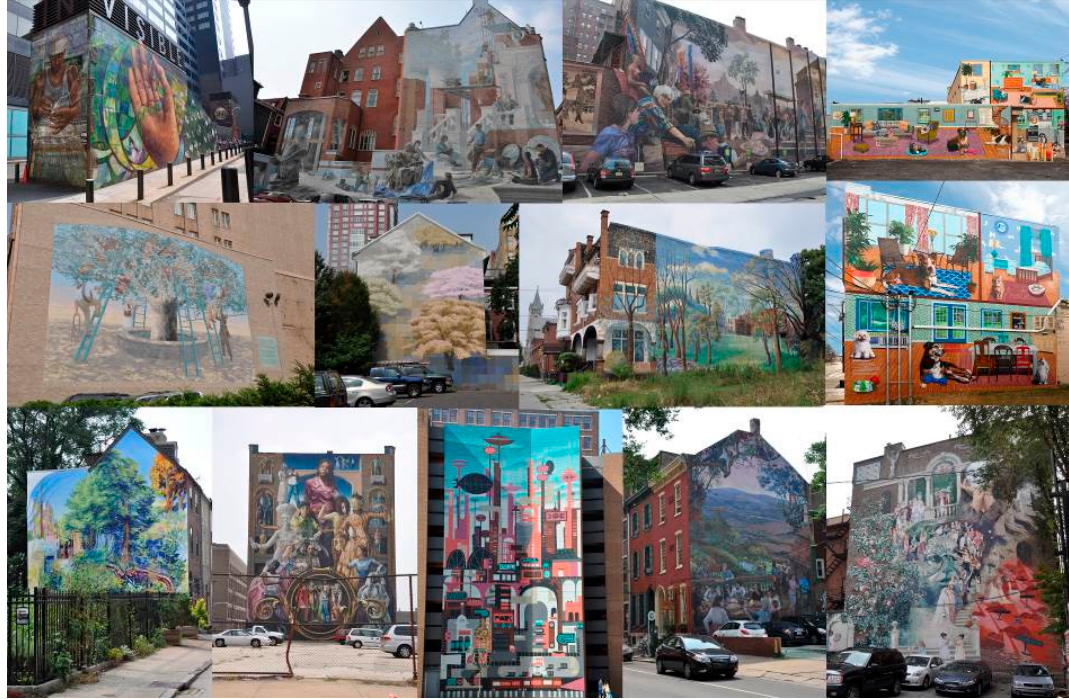
Figure 1. Some images of murals made in Philadelphia under the “Mural Arts”